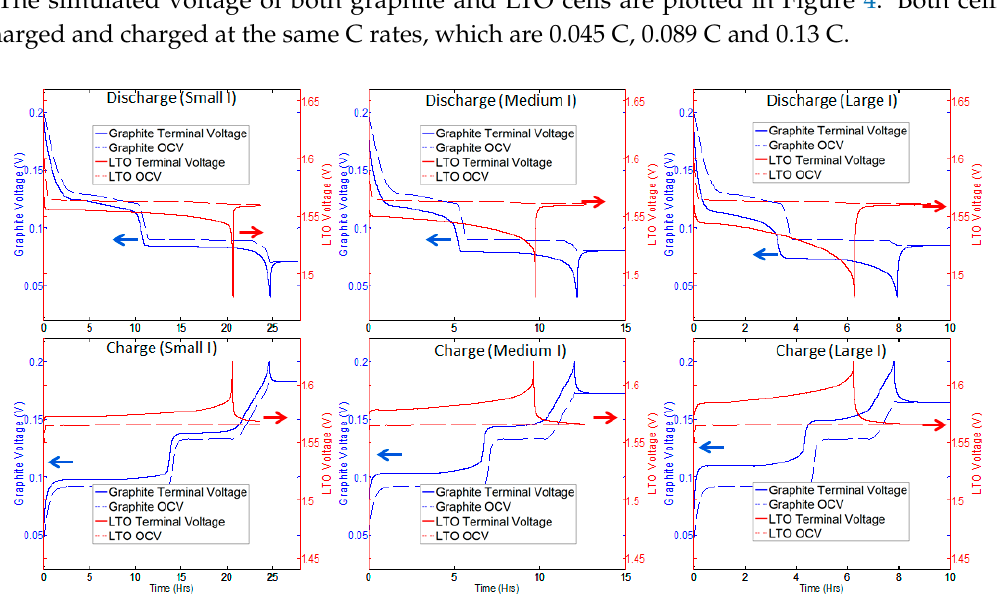
Figure 5. State of charge (SOC) comparison of graphite and LTO half-cell simulations of 0.045 C, 0.089 C, and 0.13 C cycles.